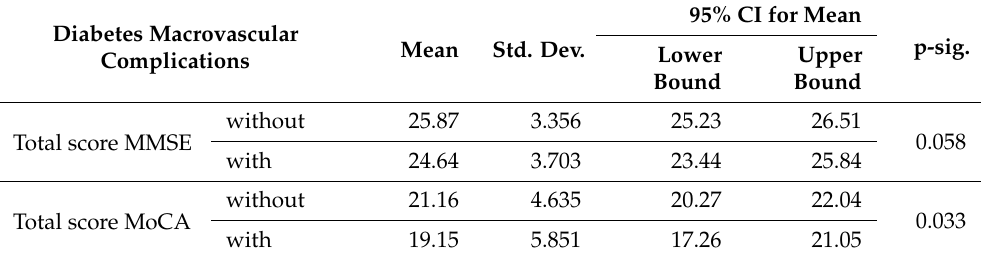
Table 7. Differences in MMSE and MoCA scores according to macrovascular complications. Diabetes